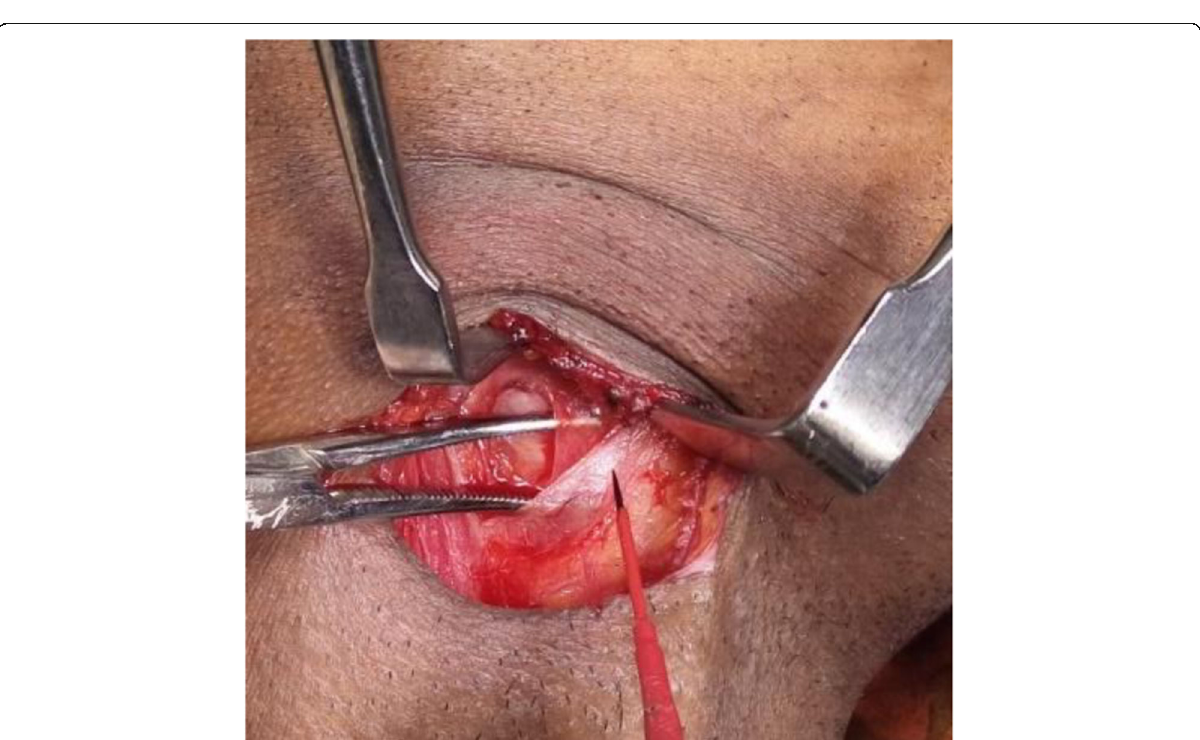
Fig. 8 Node of Stahr